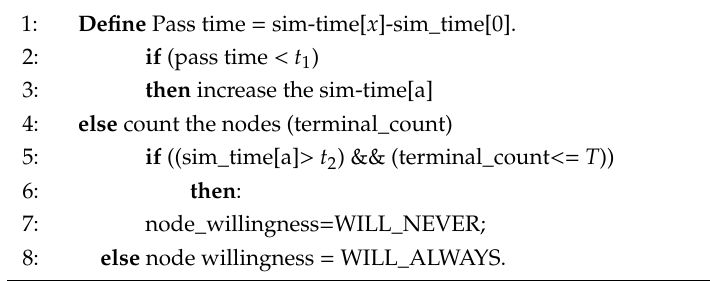
Algorithm 1: Node willingness of nodes to become MPR Improved OLSR algorithm considering node willingness and node count. Improved OLSR algorithm considering node willingness and node count. Algorithm 1:Node willingness of nodes to become MPR